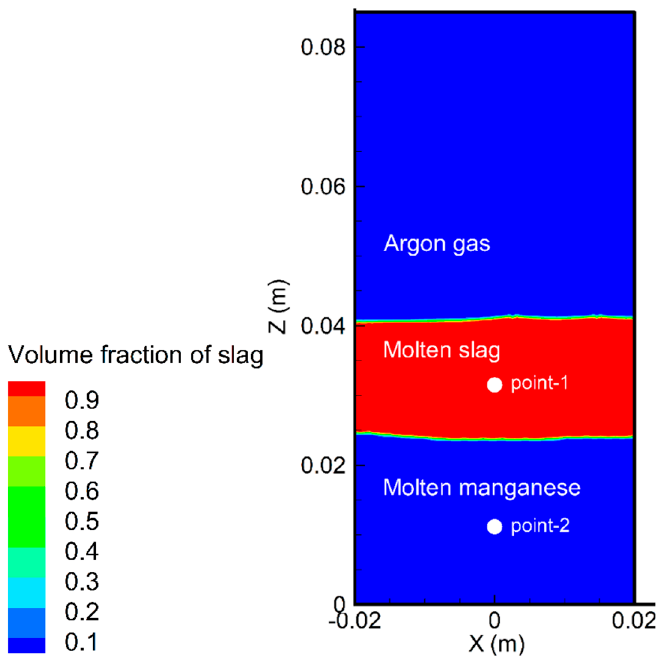
Figure 5. Distributions of the three fluids at 600 s with the 1873 K heating temperature and the two monitoring points.